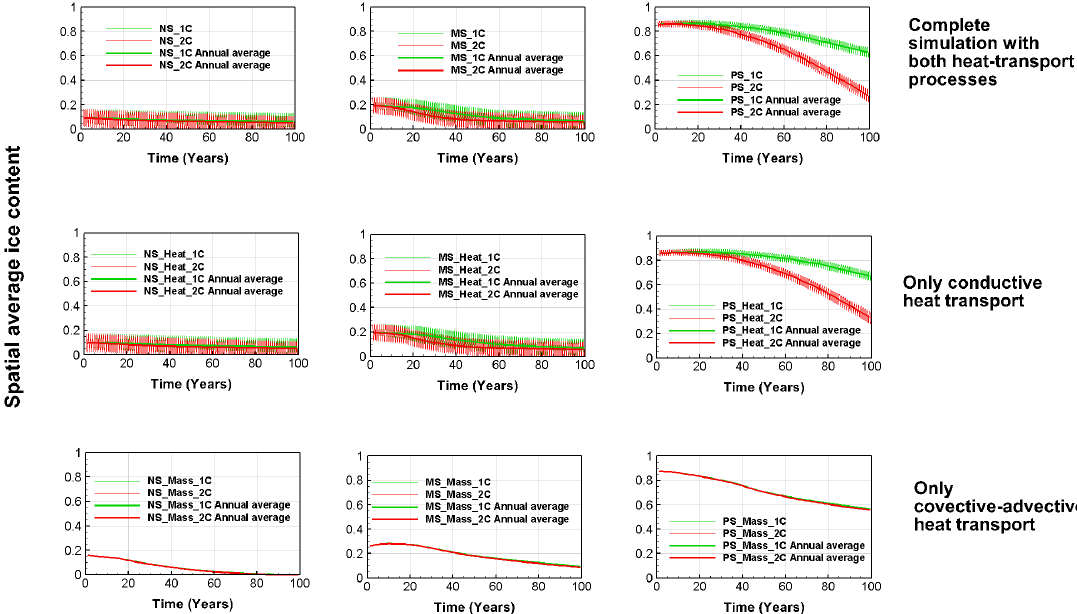
Figure 6. Evolution over time of spatial (whole domain) average ice content for different surface warming scenarios in the simulation cases of no soil (NS, left), mineral soil (MS, middle), and peat soil (PS, right), with different heat transport accounts in the simulations (both conduction and convection – advection — upper; only conduction — middle; only convection – advection — lower).